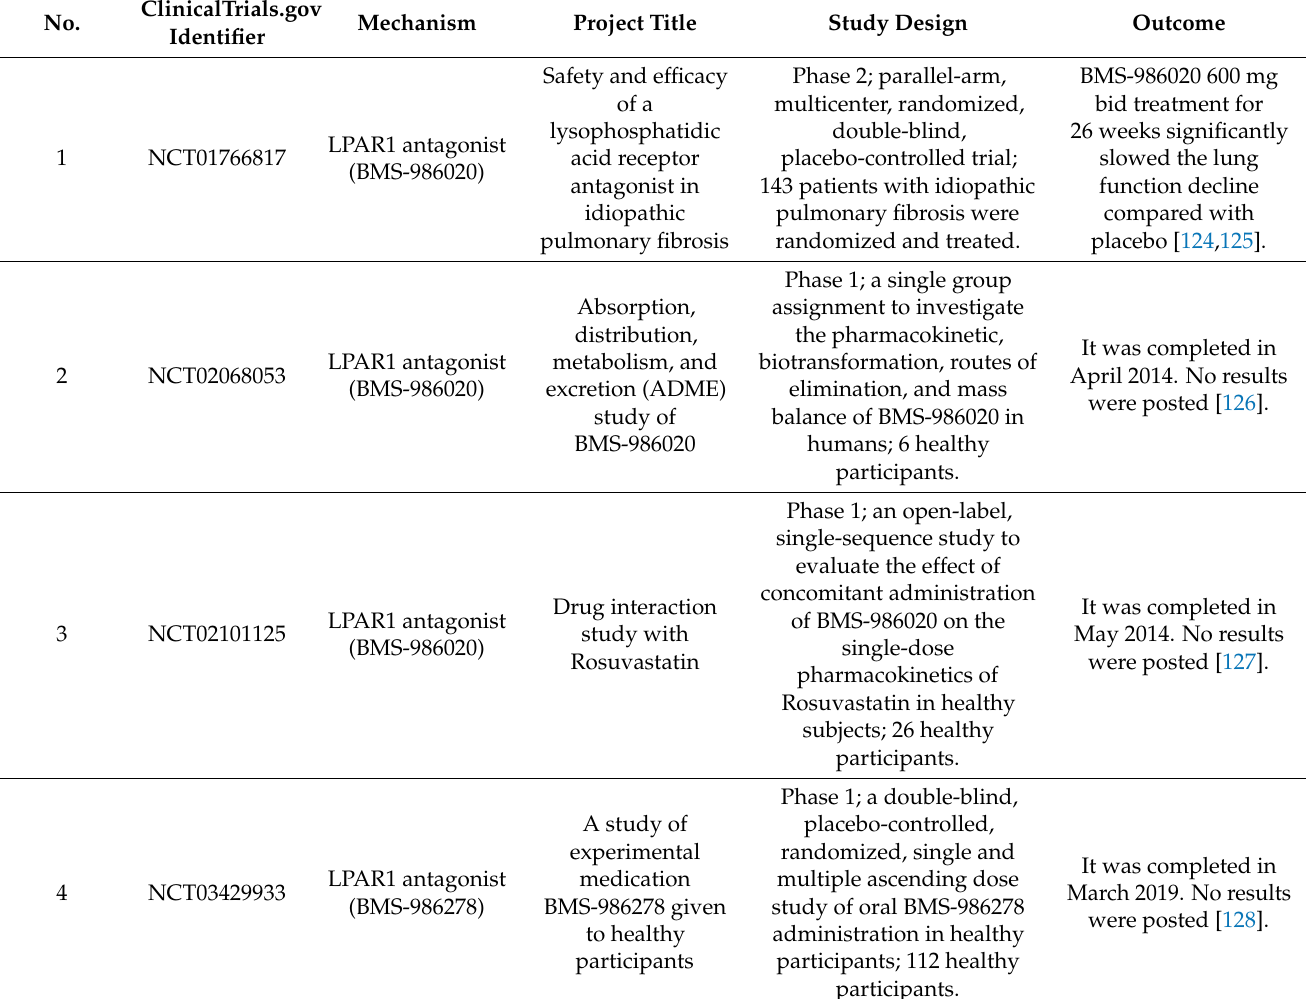
Table 1. A summary of clinical trials targeting LPA receptors